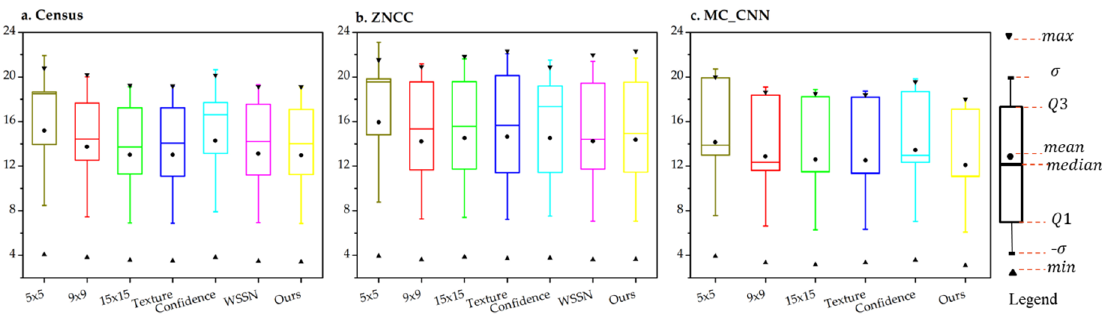
Figure 6. Boxplot of statistics from the mismatch-3 on the satellite dataset.